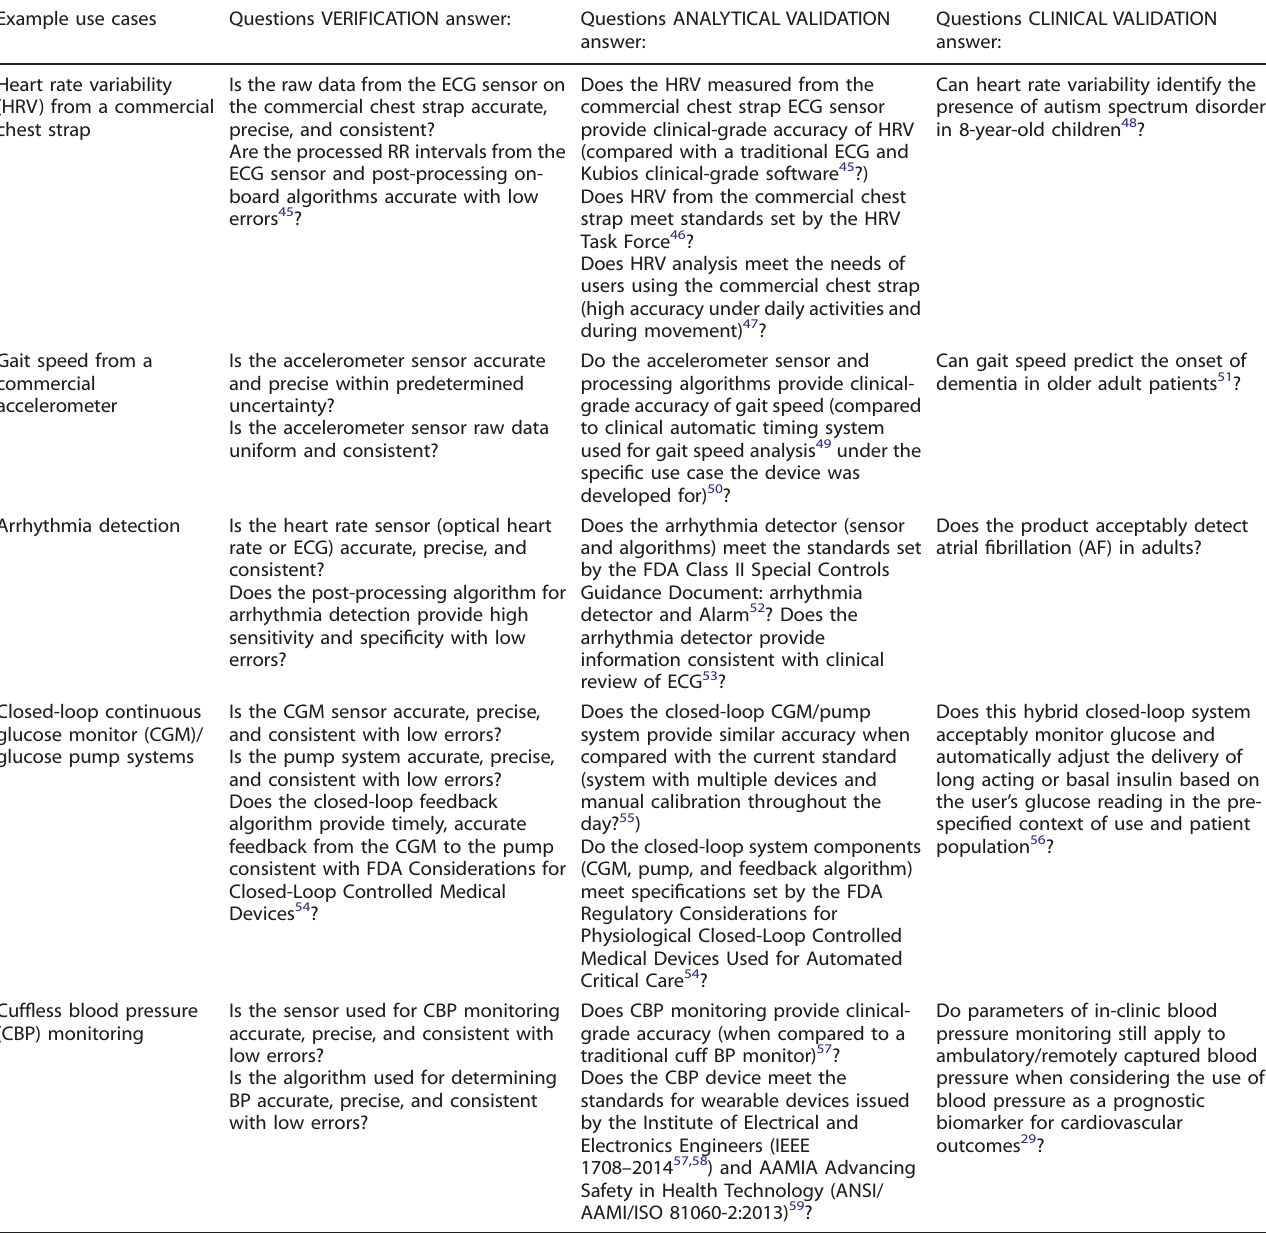
Table 8. Questions that veri fi cation, analytic validation, and clinical validation answer in example use cases. Example use